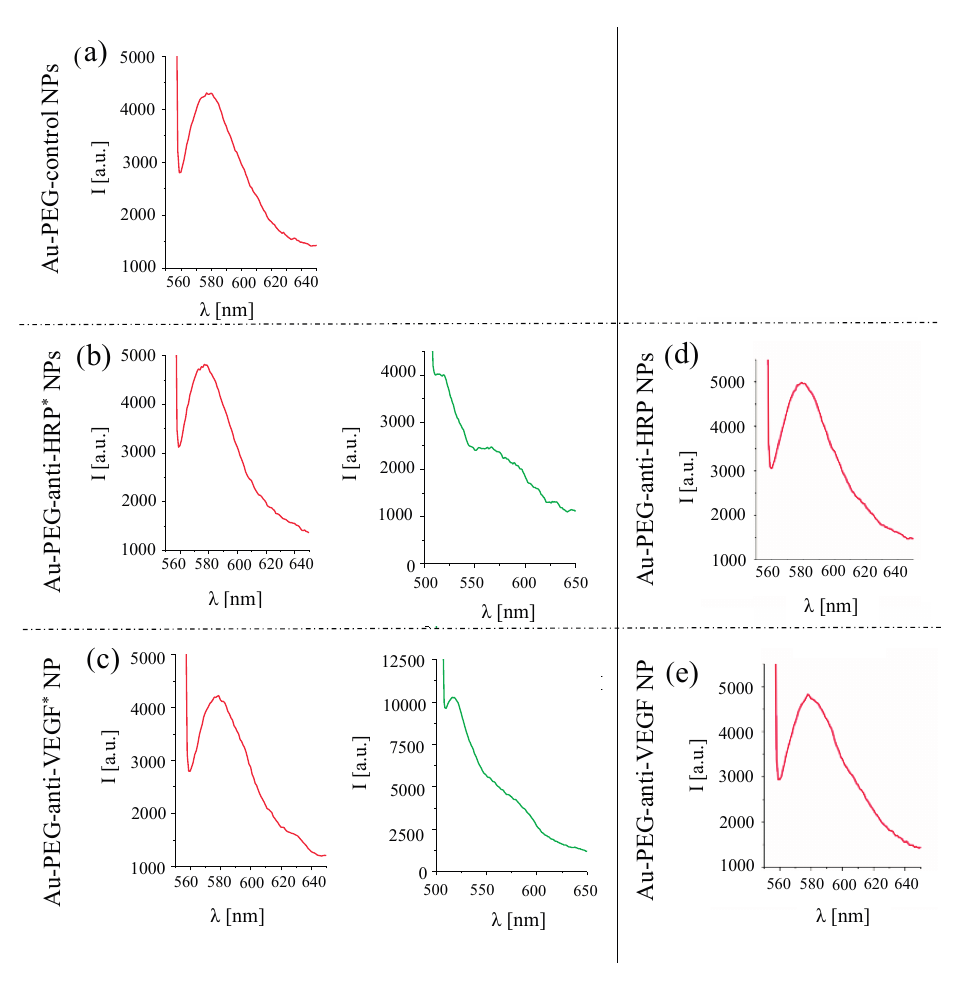
Figure 7. Left side: Fluorescence spectra recorded for ( a ) Au-PEG-control NPs, ( b ) Au-PEG-anti-HRP* NPs, and ( c ) Au-PEG-anti-VEGF* NPs at a NP concentration of c NP = 2 nM. Excitation was performed at 545 nm (TAMRA, drawn in red) or at 494 nm (FITC, drawn in green). Fluorescence spectra were recorded under the same conditions as the spectra recorded for the calibration curve Figure 5. Right side: Fluorescence spectra recorded for ( d ) Au-PEG-anti-HRP NPs, and ( e ) Au-PEG-anti-VEGF NPs for TAMRA excitation (545 nm) at a NP concentration of c NP = 2